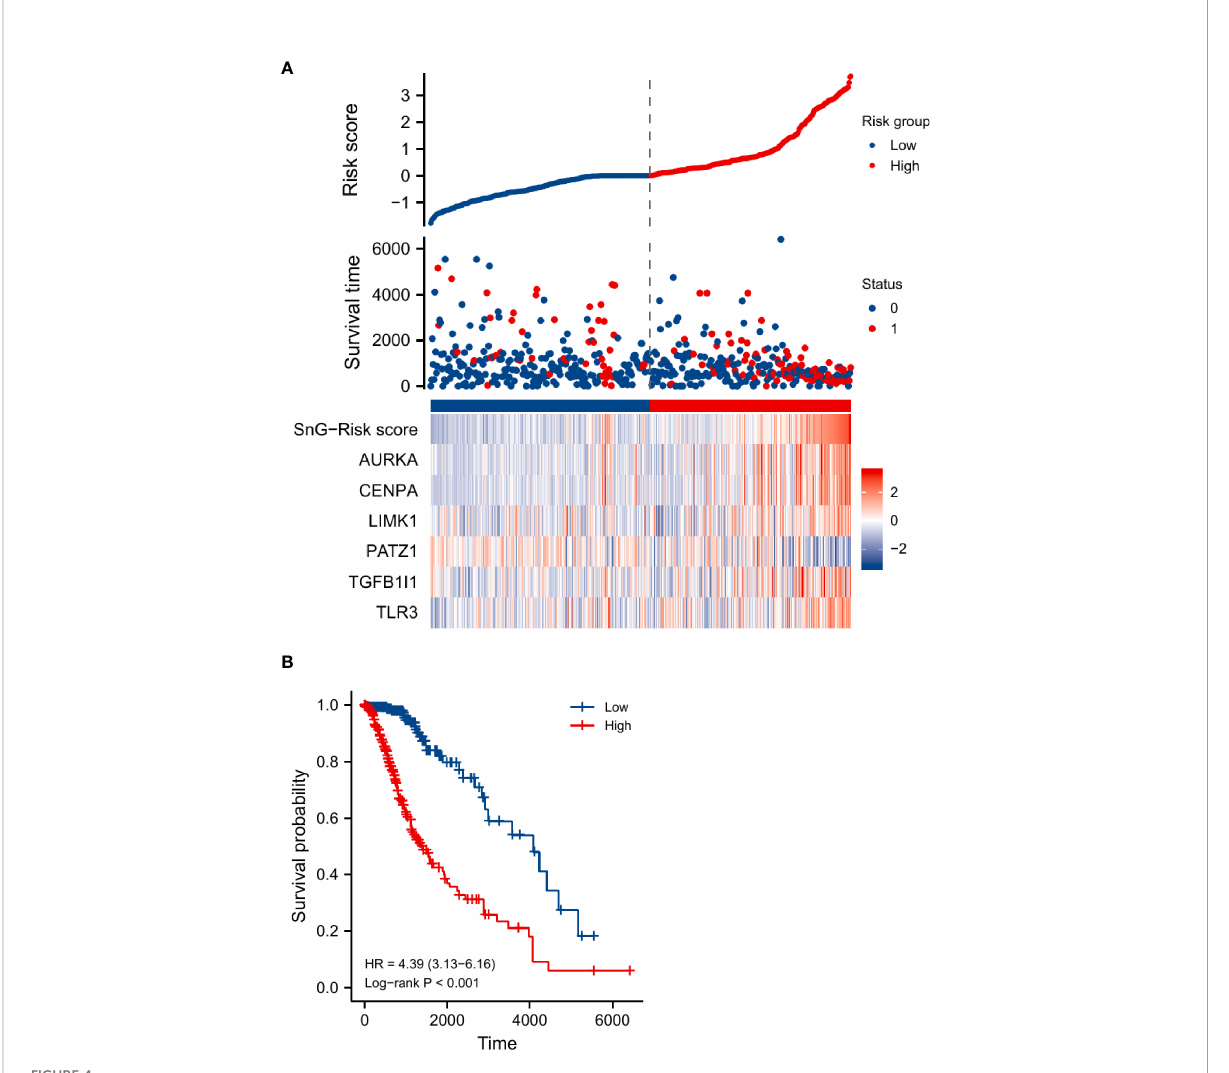
FIGURE 4 The survival distribution, risk score, and heat-map of gene-expression levels of the SnG-signature. (A) The survival distribution, risk score, and expression levels of the SnG-signature. (B) Kaplan-Meier analysis for estimation of the OS with different risk levels in